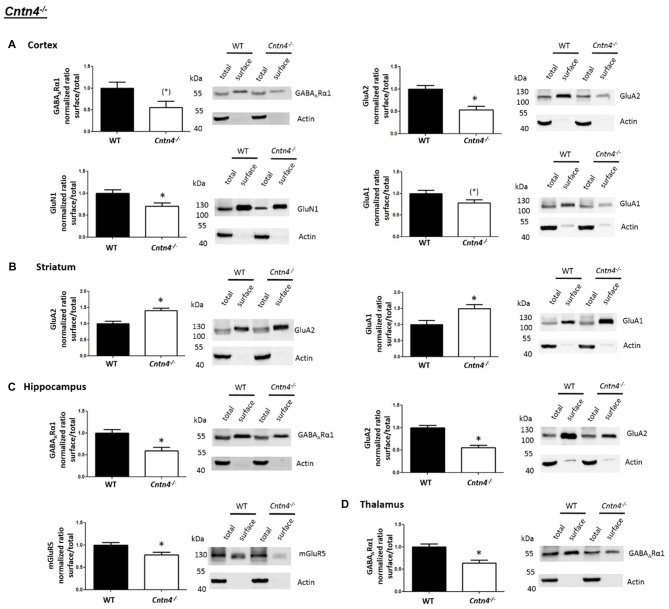
Analysis of cell surface glutamate and GABA receptor subunits in ASD related brain regions of Cntn4−/− mice. (A–D) Representative WBs showing band intensities of total protein and cell surface sample in cortex (A), striatum (B), hippocampus (C) and thalamus (D) of wildtype and Cntn4−/− mice reveal a dysregulation of cell surface glutamate and GABA receptor subunits in Cntn4−/− mice. Immunodetections were carried out with antibodies directed against GABAARα1, GluA2, GluN1, GluA1, mGluR5, and actin. For GABAARα1, GluA2, and actin all brain regions were analyzed. For GluN1 all brain regions except the cerebellum were analyzed. For GluA1 all brain regions except the thalamus and cerebellum were analyzed. For mGluR5 only the hippocampus was analyzed. Only statistically significant data (p < 0.05; see below) or data with strong trends (p < 0.10; see below) is shown. To the left of each representative WB, the respective quantification of the surface/total ratio is shown. Vertical axis shows the mean fold change vs. the wildtype control (control set to a value of 1). Error bars are SEMs. n ≥ 5 per group. *p < 0.05, (*)p < 0.10.